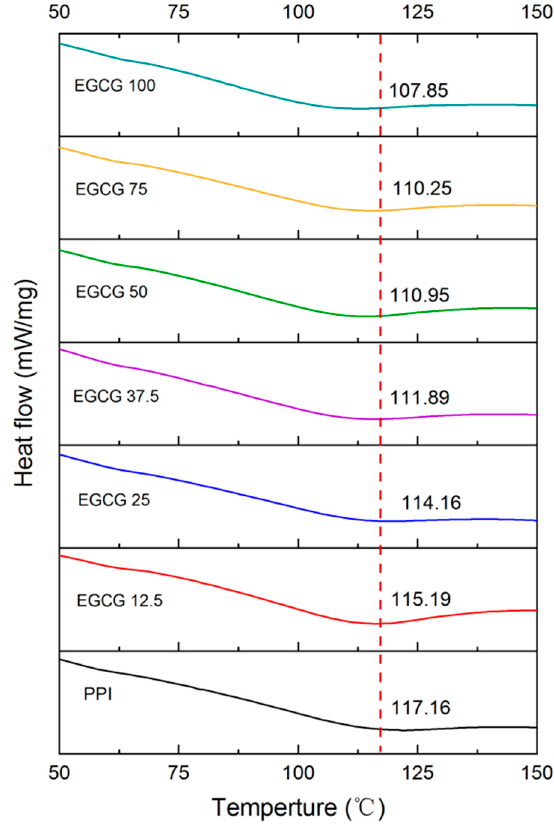
Figure 6. The heat flow curves of PPI with different EGCG concentrations.